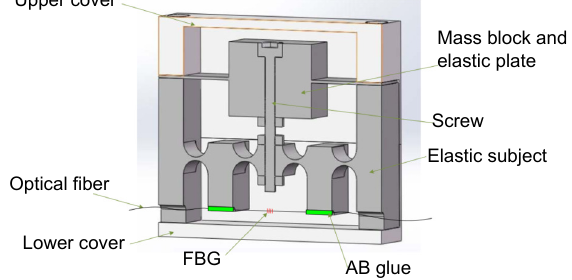
Fig. 18 | A miniature FBG vibration sensor. Figure reproduced with permission from ref. 85 ,